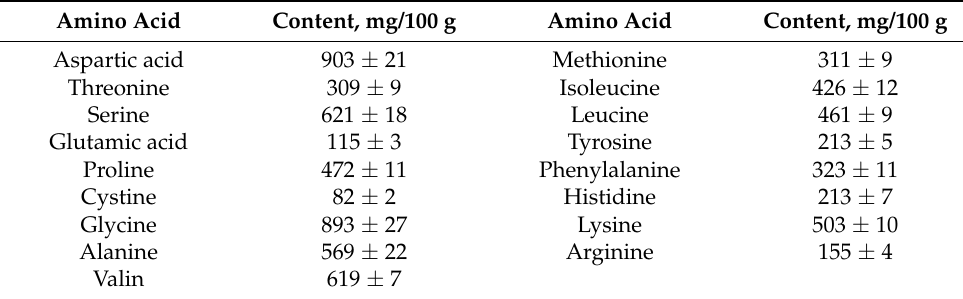
Table 2. The content of amino acids in the herb extract of A. eupatoria